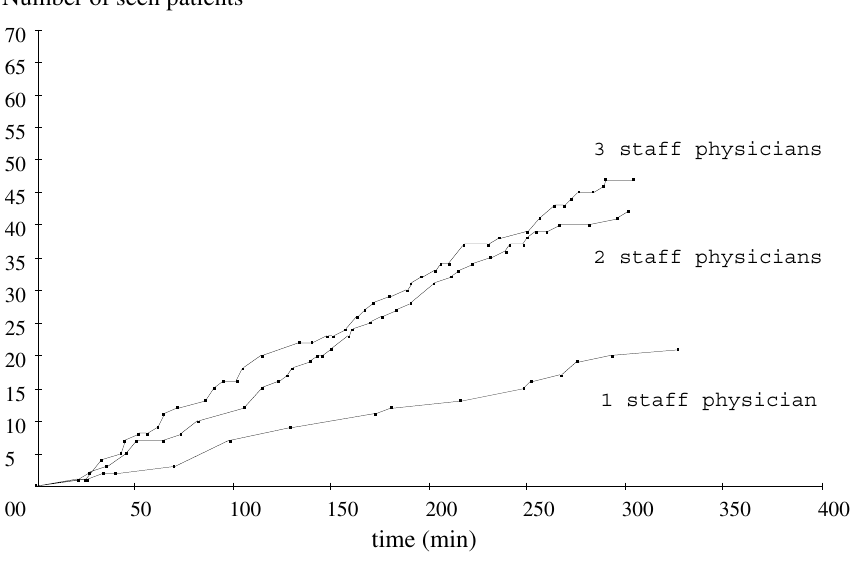
Simulating the num- ber of patients seen in an outpatient clinic with ten resident physicians and one, two or three senior staff physicians. The example includes a mix of five novice and five experienced resident physicians.